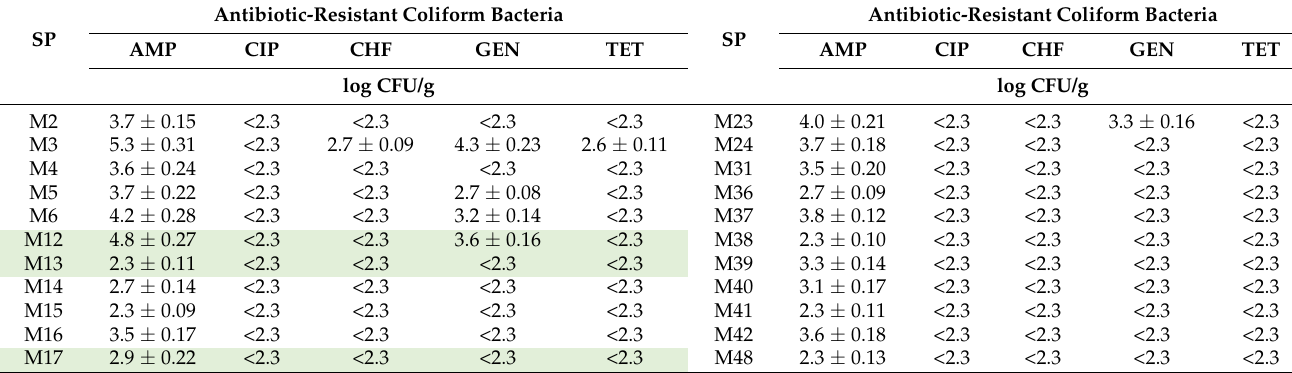
Table 7. Occurrence of antibiotic-resistant coliform bacteria and enterococci in samples of flour and